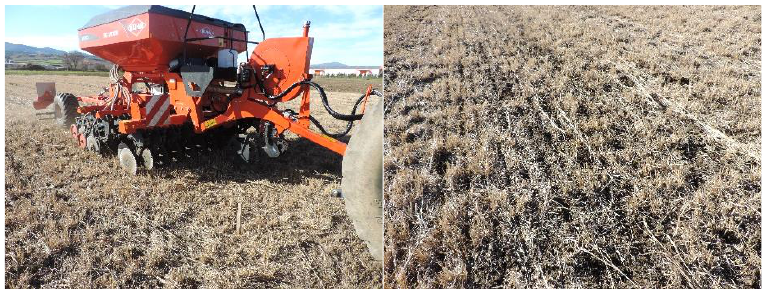
Figure 2. Pea and Vetch sow using no-till machine in an existing switchgrass cultivation.